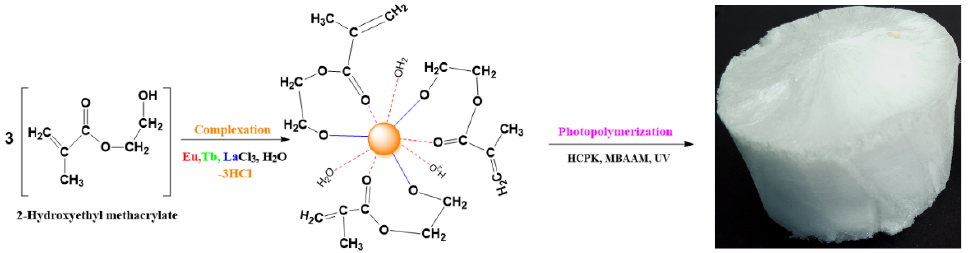
Figure 1. Complexation reaction and the obtained aerogel after photopolymerization.